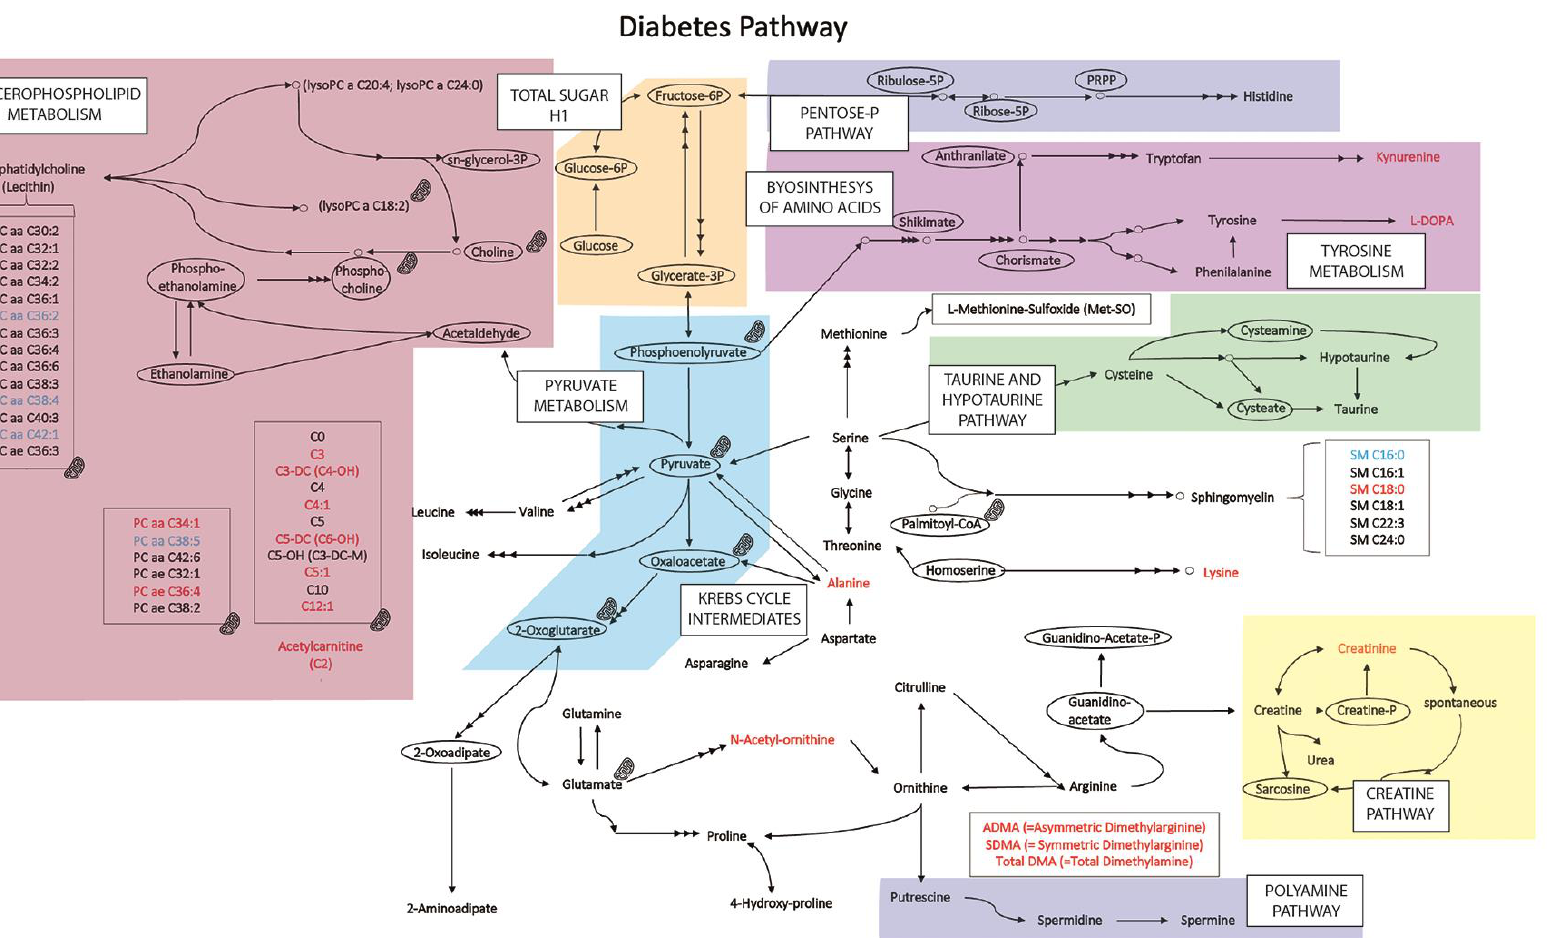
Figure 3. Metabolic pathway map summarizing the results. In light blue, the metabolite whose concentration is reduced in diabetes samples; and in red, the metabolites whose concentration is increased in the diabetes samples (compared with values in samples from healthy controls). Molecules whose concentration was not determined are within ellipses; they are included as nodes in metabolism interconnections. Areas in color represent the main metabolic pathways. The mitochondria symbol indicates a molecule/group of molecules that may be in mitochondria or are directly/indirectly related to mitochondria.